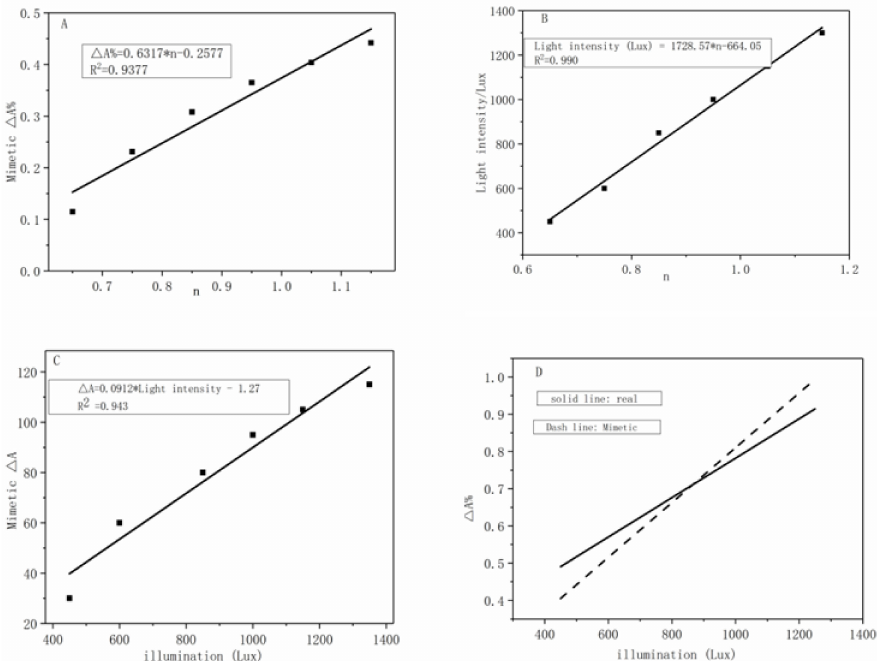
Figure 9. ( A ) Linear relationship between n and the rate of change in the amplitude of the simulated oscillation; ( B ) linear relationship between n and the actual intensity; ( C ) rate of change of the amplitude of the light intensity versus the simulated oscillation; ( D ) linear relationship between actual light intensity and the rate of change of the amplitude of the actual oscillation pattern and the simulated oscillation